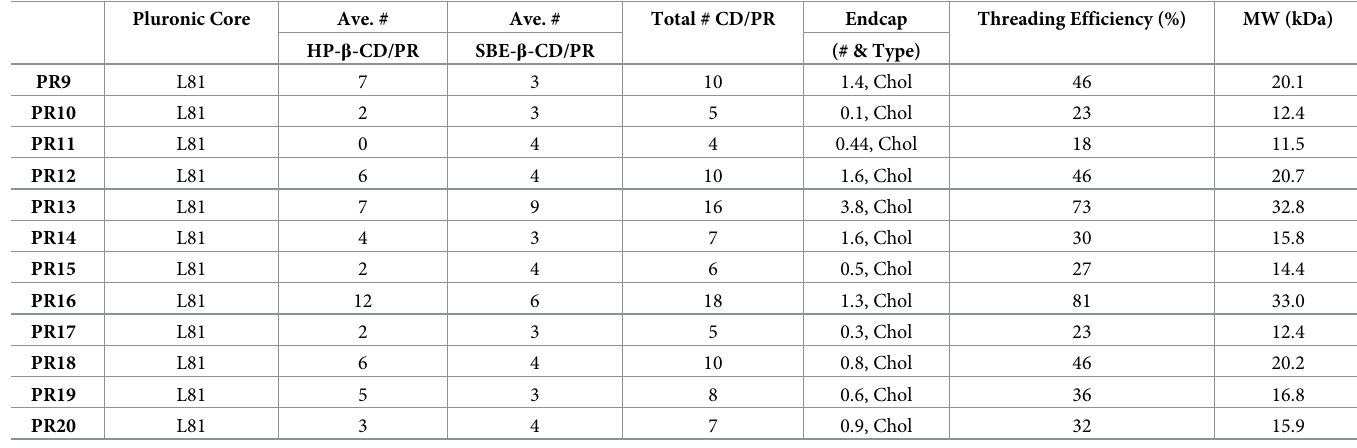
Table 2. Compositions observed for cholesterol-endcapped TAEA-L81 Pluronic polyrotaxane library prepared by mechanochemical synthesis. Pluronic Core Ave. # Ave.